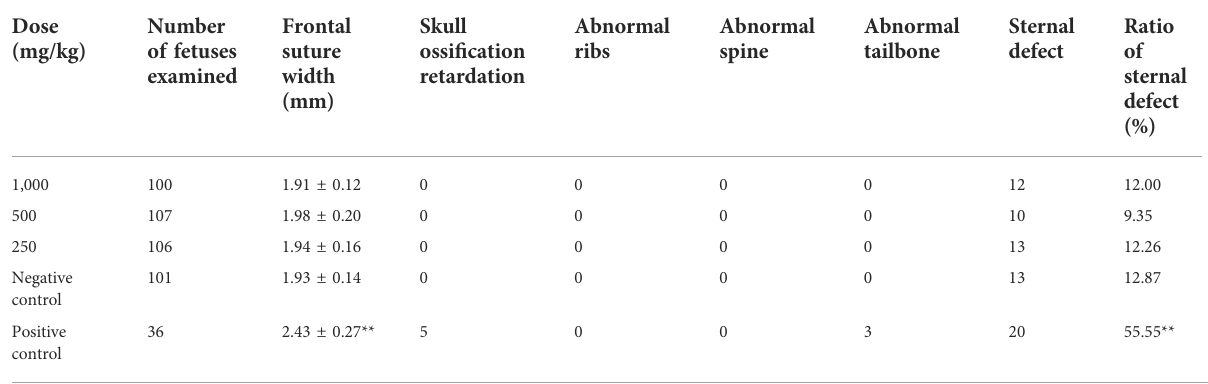
TABLE 5 Effects of water-extract sericin on skeletal malformations of